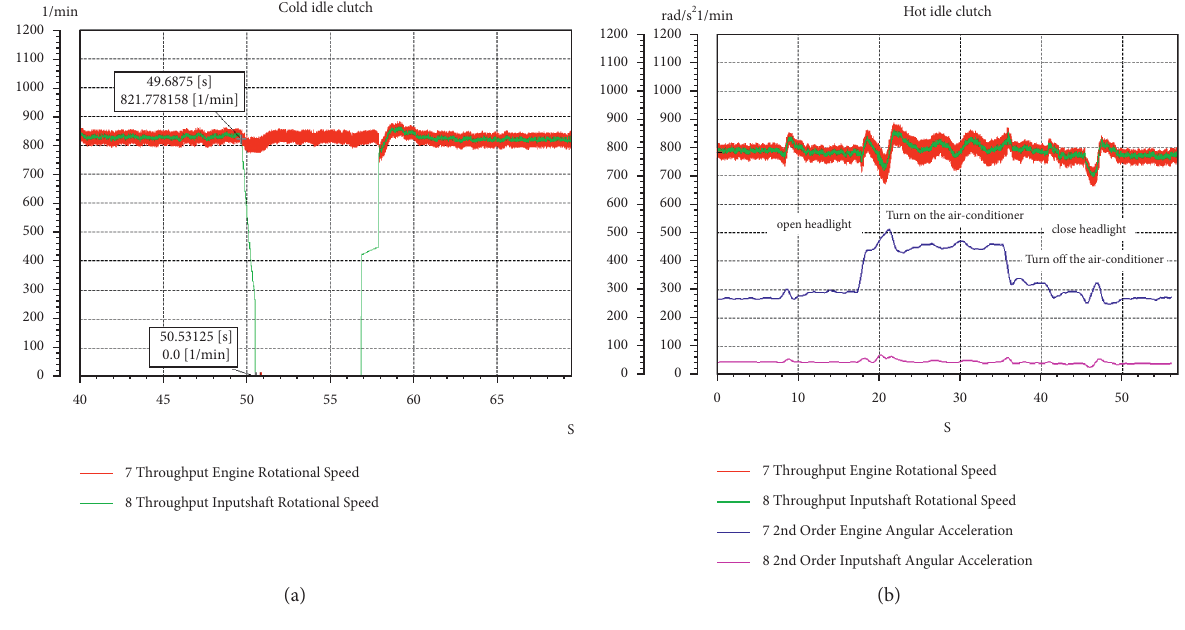
Figure 10: Idle conditions. (a) Cold idle clutch. (b) Hot idle